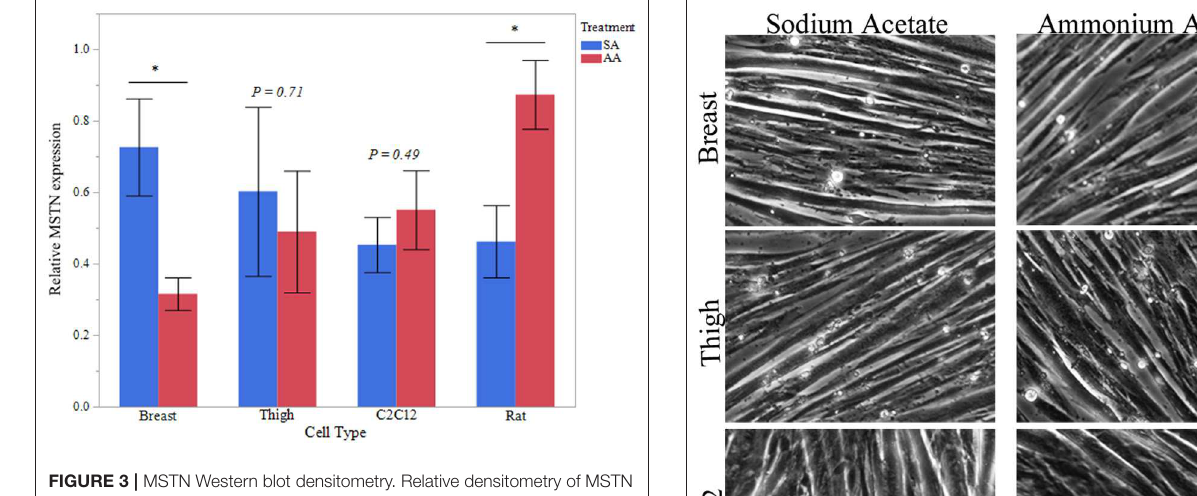
FIGURE 3 | MSTN Western blot densitometry. Relative densitometry of MSTN protein from myotubes from C2C12 cells, primary breast, primary thigh, or primary rat cultures after treatment with ammonium acetate (10mM) or sodium acetate (10mM) for 24h ( n = 4 independent samples). MSTN expression is relative to β -actin for each sample. Asterisks represent significant differences between treatments of each cell type (* P < 0.05; ** P < 0.01).